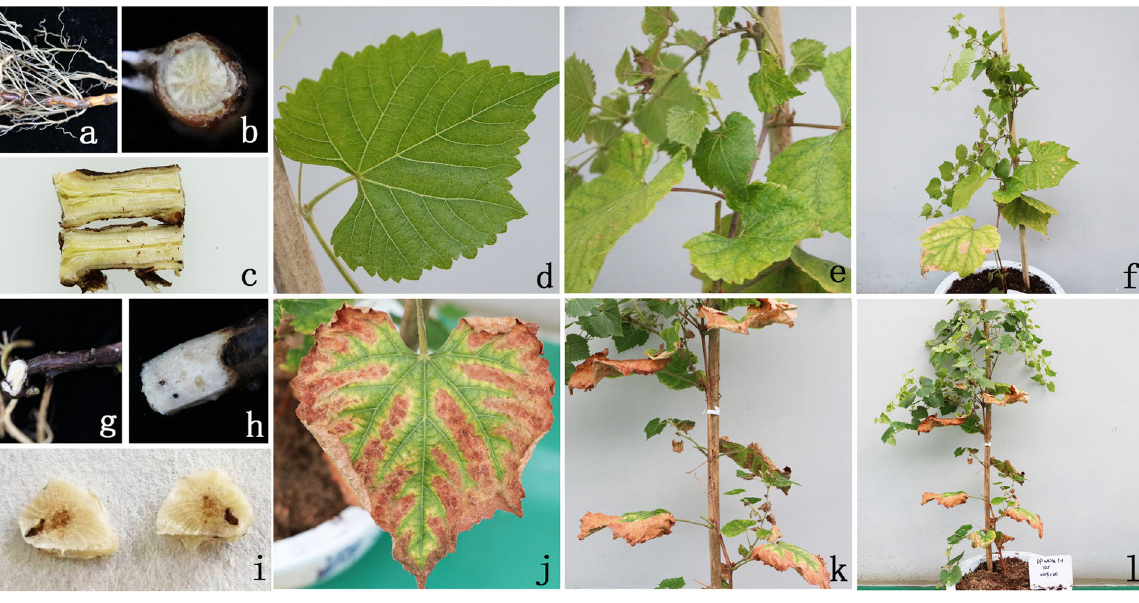
Fig. 6 Pathogenicity test of Phaeoacremonium minimum in the greenhouse. a – f Control plant. g – l The Plant inoculated with P. minimum showed interveinal discolorations and necrosis on leaves, and black necrosis within rootstock at 208